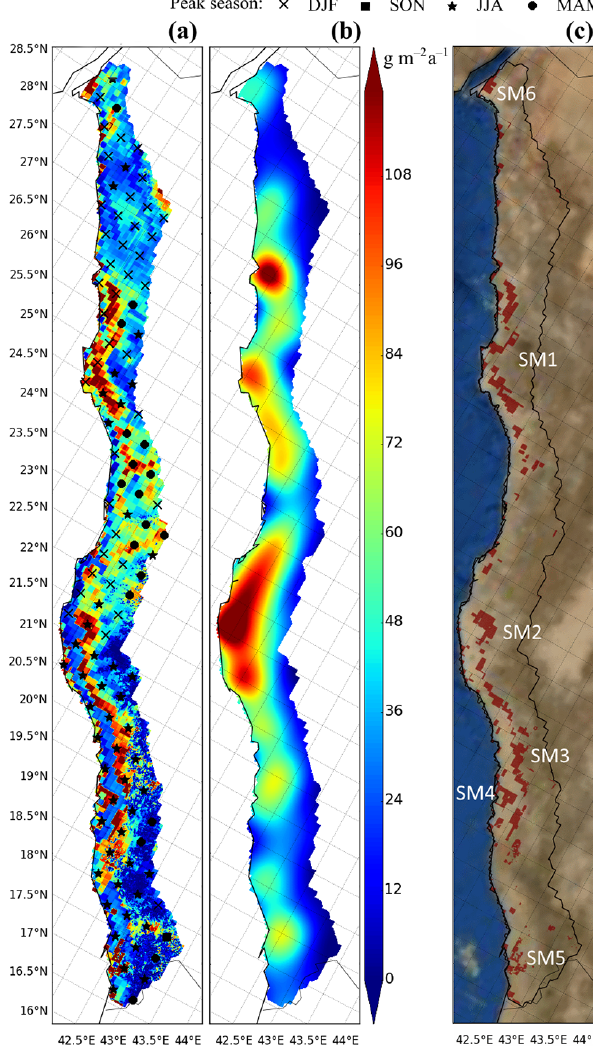
Figure 4. Annual dust emission (gm − 2 a − 1 ) in (a) 1kmALL exper- iment with SEVIRI source function (2009–2011); (b) MERRAero (2003–2015). (c) Main dust emission hot spot areas mapped on real- color satellite image. Peak season is indicated by symbols (see fig- ure legend).